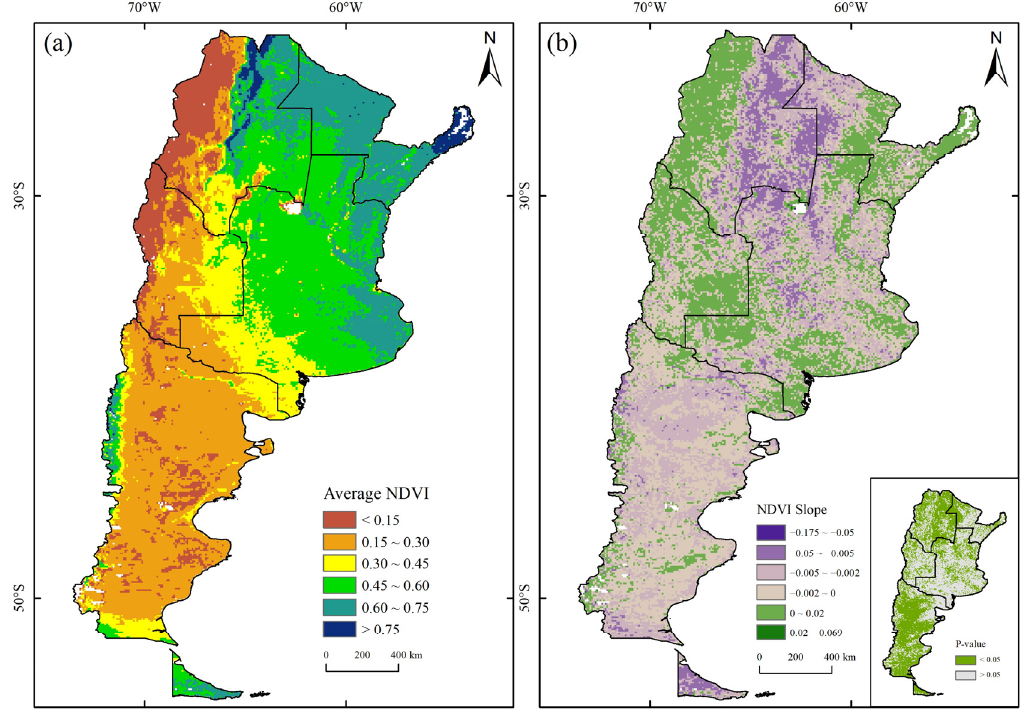
Figure 4. ( a ) Average NDVI. ( b ) NDVI trend in Argentina from 1982 to